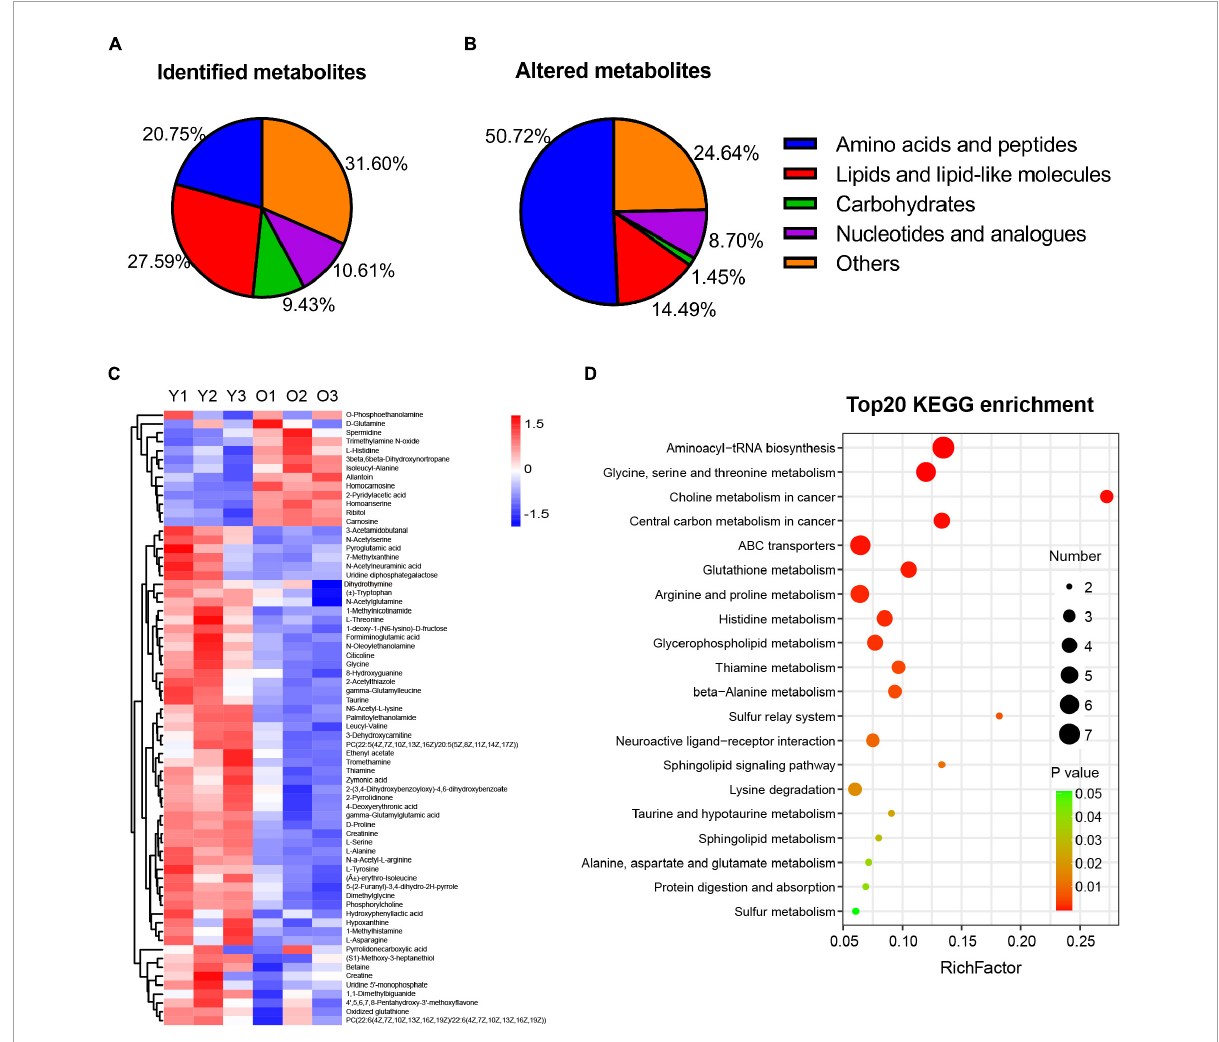
FIGURE3 Metabolic profiling and altered metabolism-related pathways of hippocampus tissue in male aged mice. (A,B) Pie graph of the metabolites class composition of identified and significantly altered metabolites in the hippocampus of male aged mice. (C) Hierarchical heatmap analysis of the relative content of DEMs in hippocampus from male aged (O1–O3, n = 3) and young mice (Y1–Y3, n = 3). (D) Bubble illustration of top20 ranked enriched KEGG pathway terms. The diameter of the solid circle denotes the number of DEMs enriched and the color showing the p -value in the corresponding